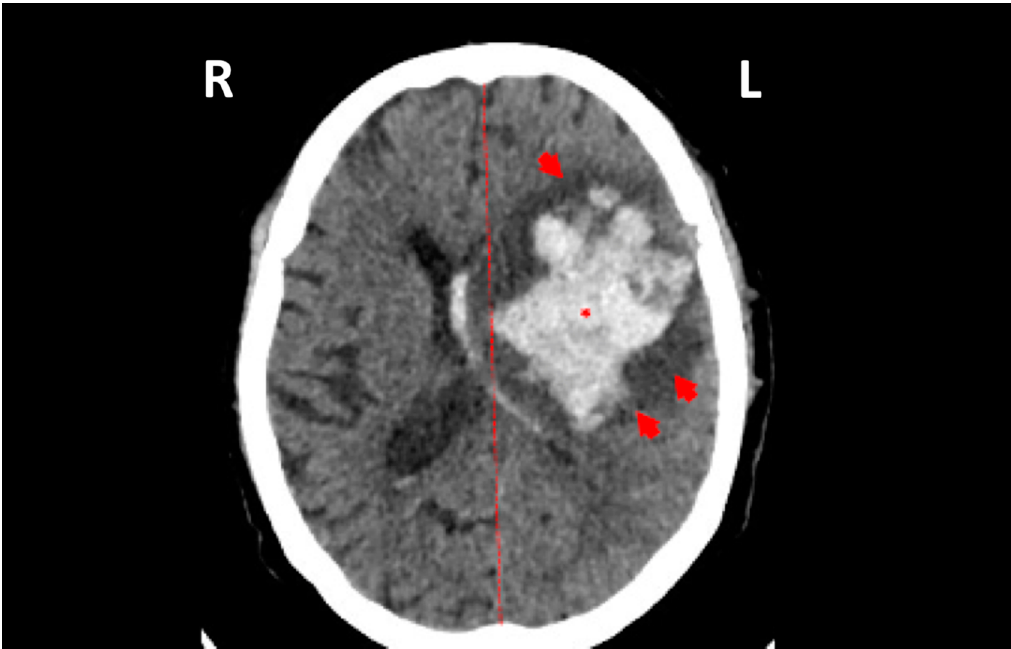
Figure 1. Computed tomography imaging of the patient’s brain showing an intraparenchymal hemorrhage (asterisk) surrounded by a brain edema (red arrows), as well as deviation from the cerebral middle line (red